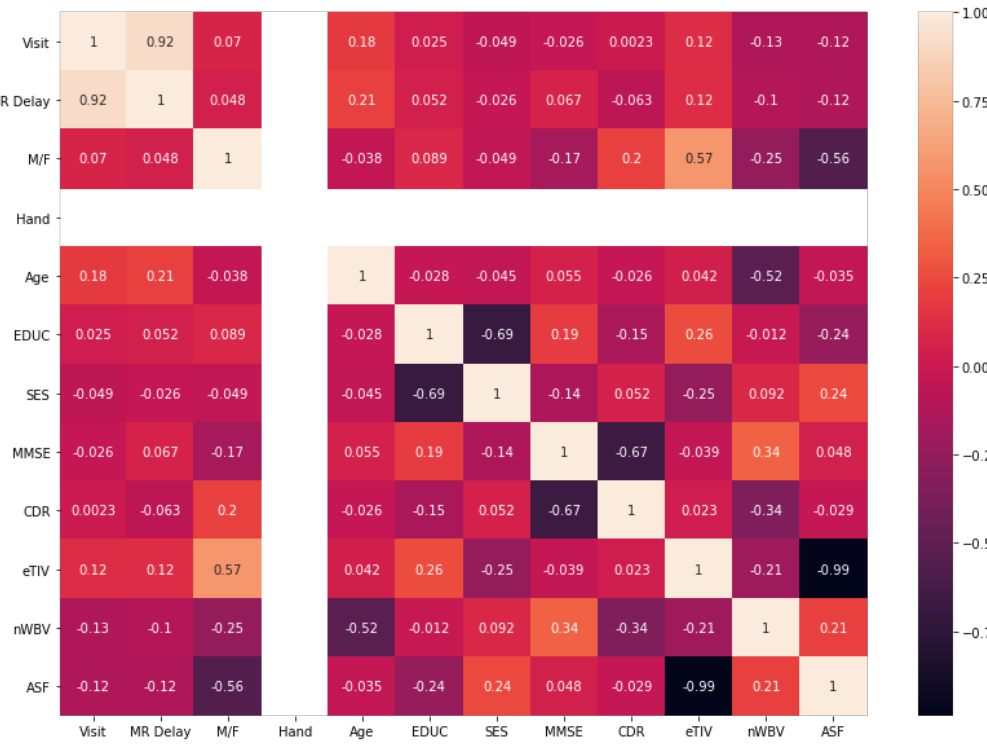
Figure 3. Correlation matrix heatmap after processing of missing